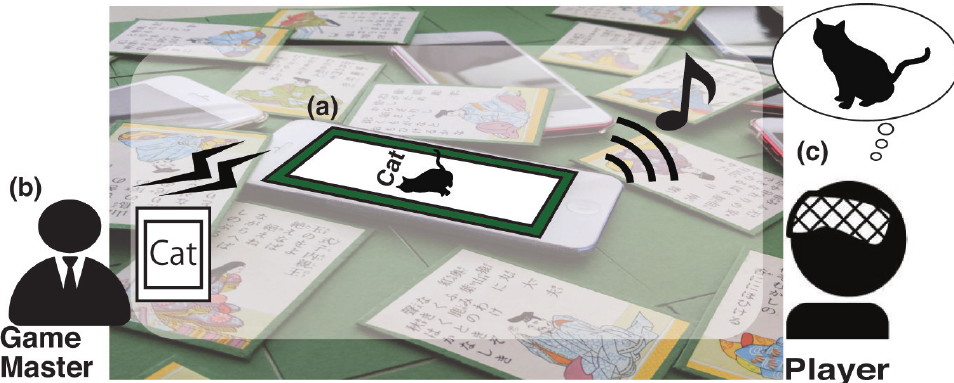
Figure 2. System overview: ( a ) a small tablet device regarded as a card: an audible card. ( b ) The game master plays an audio signal from the audible card by wireless connected device. ( c ) Players recognize the information of the card through acoustic